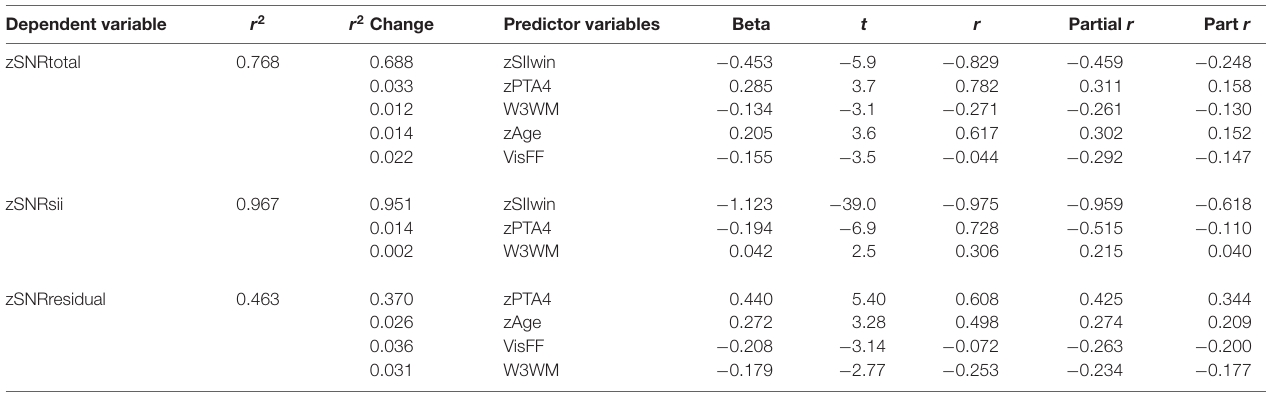
TABLE 3 | The results of the linear-regression analyses for the z-transformed WIN SNR components at SRT. Dependent